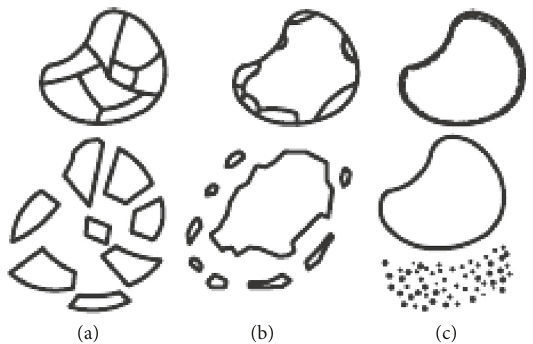
Figure 2: Schematic diagrams of the types of particle breakage. (a) Rupture. (b) Fracture. (c) Grind.